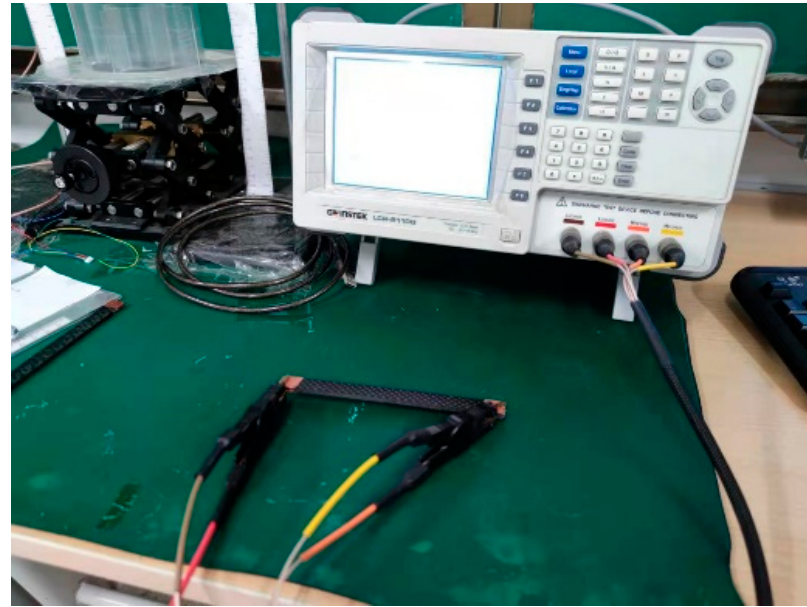
Figure 11. Impedance analyzer measures the rate of change of resistance.